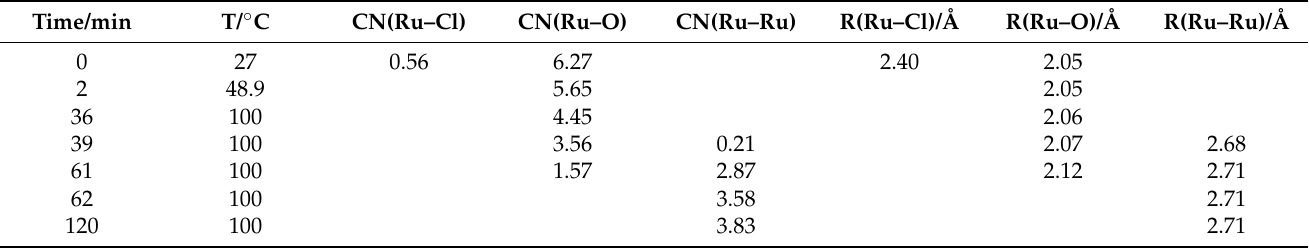
Table 1. Fitting parameters of the Ru ‐ Cl, Ru ‐ O, and Ru–Ru bonds obtained from the Ru K ‐ edge EXAFS spectra of the reaction mixture for preparing unprotected Ru nanoclusters. Reproduced with